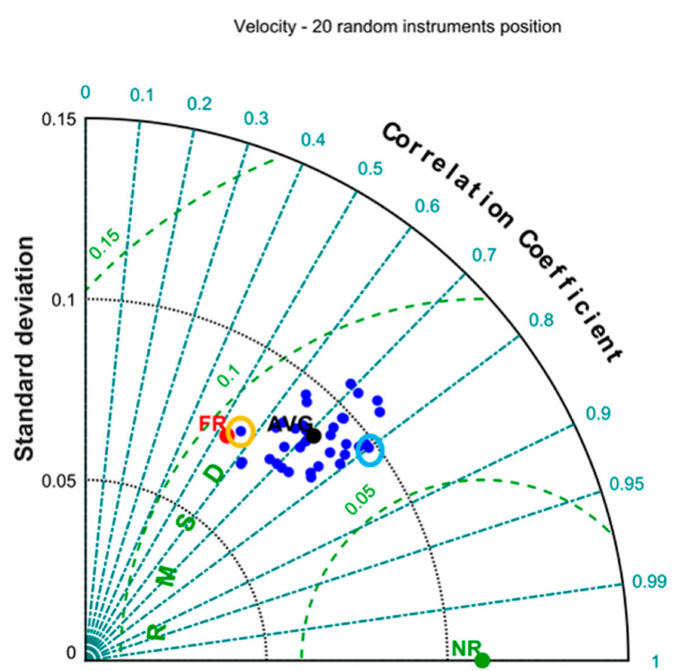
Figure 5. Representation of the ensemble of the analyses obtained from the assimilation of di ff erent datasets of velocity fields from 20 observation points randomly positioned (blue points), the Free Run (red point), and the Nature Run (green point) in the first assimilation window. The orange circle indicates the M dataset, whereas the cyan circle indicates the U dataset, which Figure 6 refers